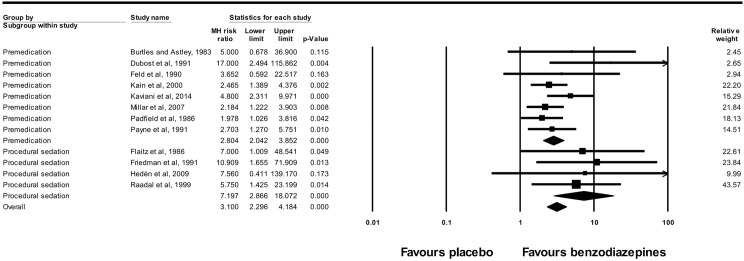
Forest plot of the meta-analysis performed to compare amnestic effects between benzodiazepines and placebos analyzed by subgroups.Premedication: RR = 2.80; 95% CI: 2.04–3.85, P<0.001; Procedural sedation: RR = 7.20; 95% CI: 2.87–18.07, P<0.001; Overall: RR = 3.10; 95% CI: 2.30–4.18, P<0.001. Heterogeneity: premedication I2 = 16%, P = 0.30; procedural sedation I2 = 0%, P = 0.96; overall I2 = 14%, P = 0.30.